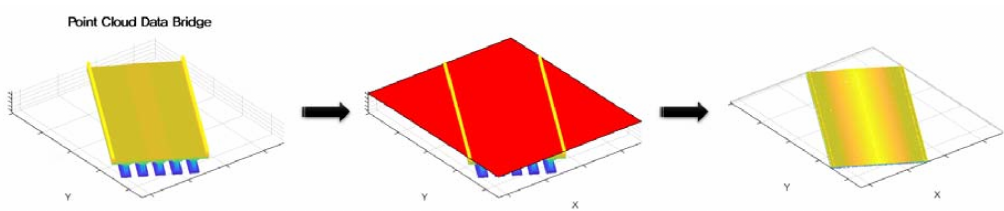
Figure 4. Procedure for plane prediction using the m-estimator sample consensus (MSAC).